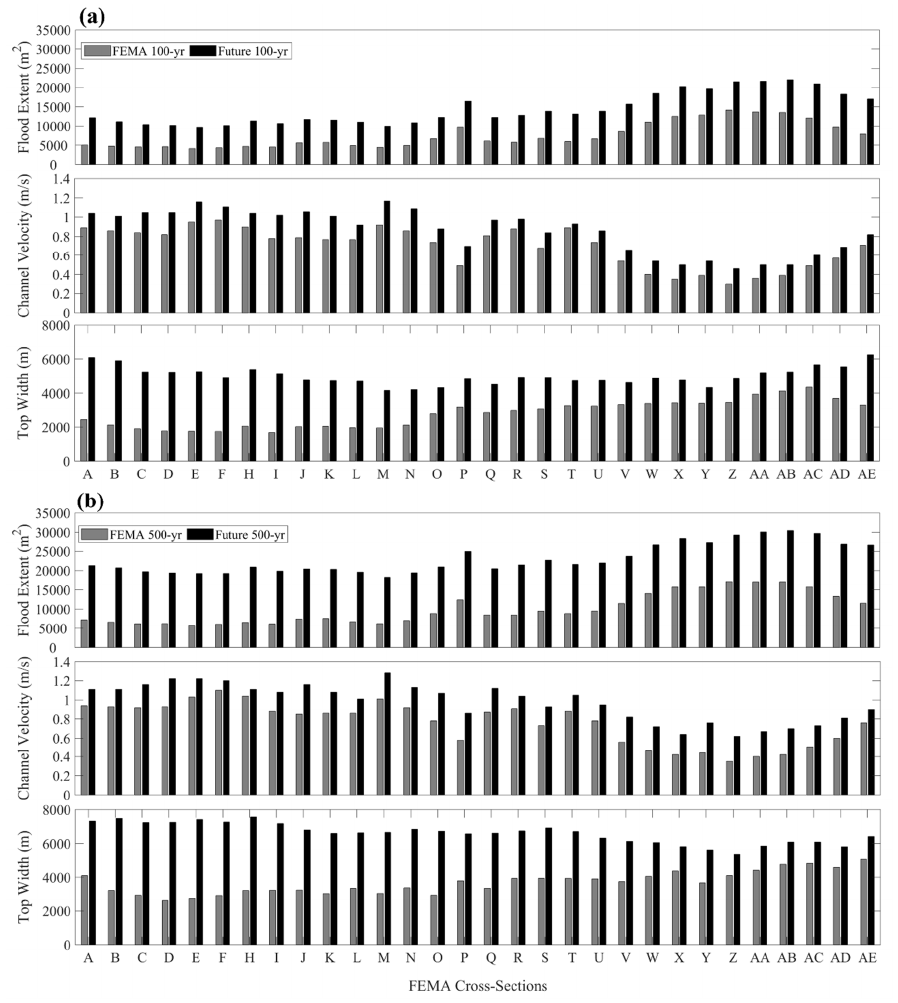
Figure 7. Comparison of flood characteristics such as flood extent, channel velocity, and top width for different flooding scenarios considering ( a ) 100-year and ( b ) 500-year return period flood events, respectively.